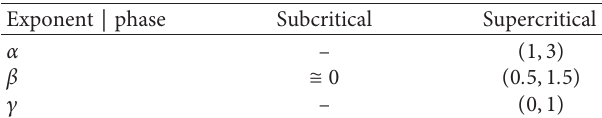
Table 1: Interval features of critical phases. The symbol “–” symbol means a power law